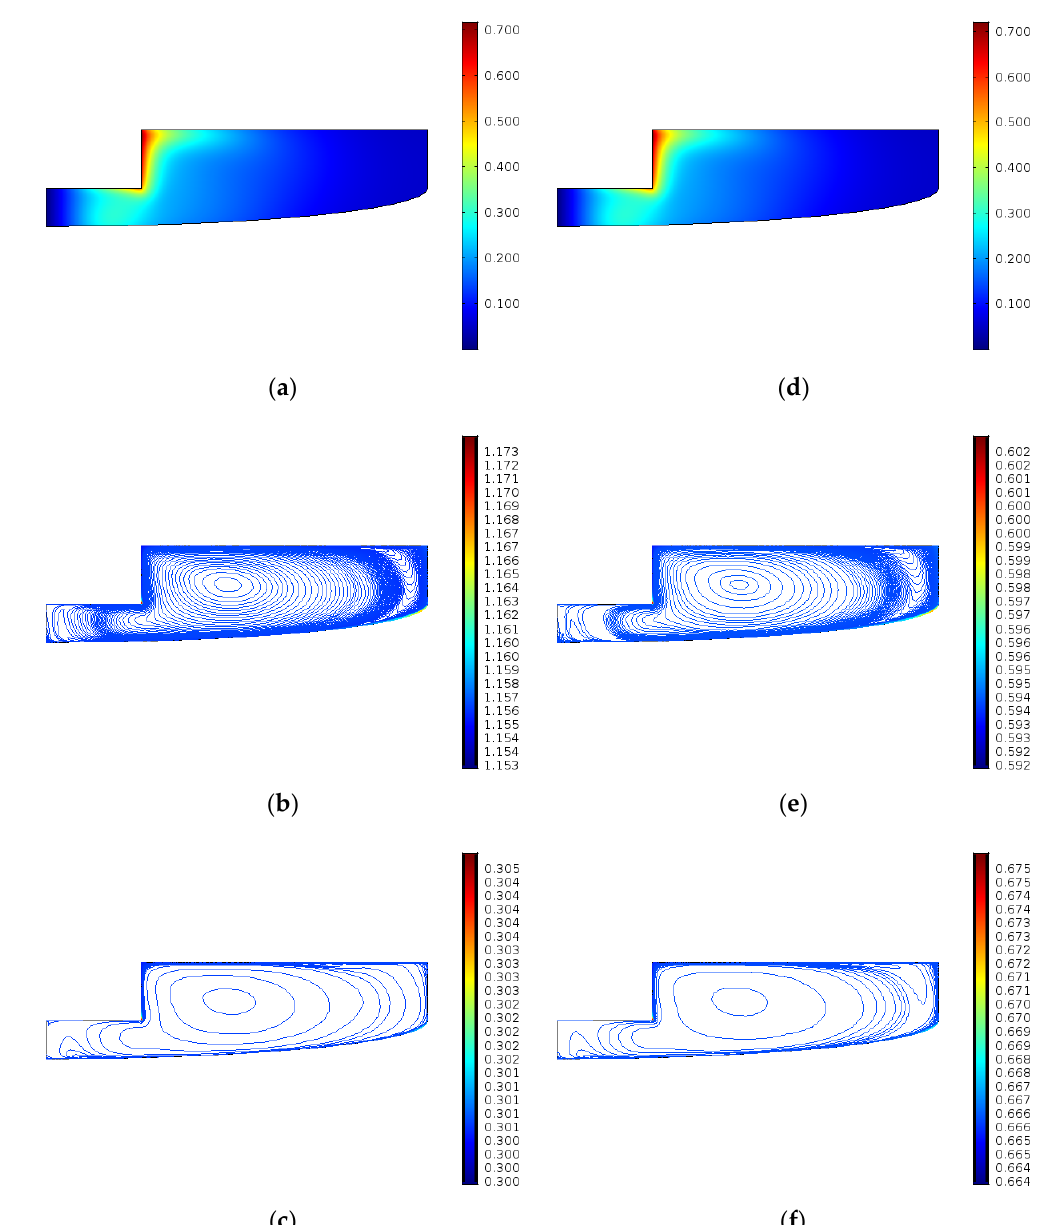
Figure 6. Results after 4 h ( a ) velocity field (m/s) in case of experiment 3; ( b ) ECSO concentration (mol/m 3 ) in case of experiment 3; ( c ) CO 2 concentration (mol/m 3 ) in case of experiment 3; ( d ) velocity field (m/s) in case of experiment 13; ( e ) ECSO concentration (mol/m 3 ) in case of experiment 13; ( f ) CO 2 concentration (mol/m 3 ) in case of experiment 13.